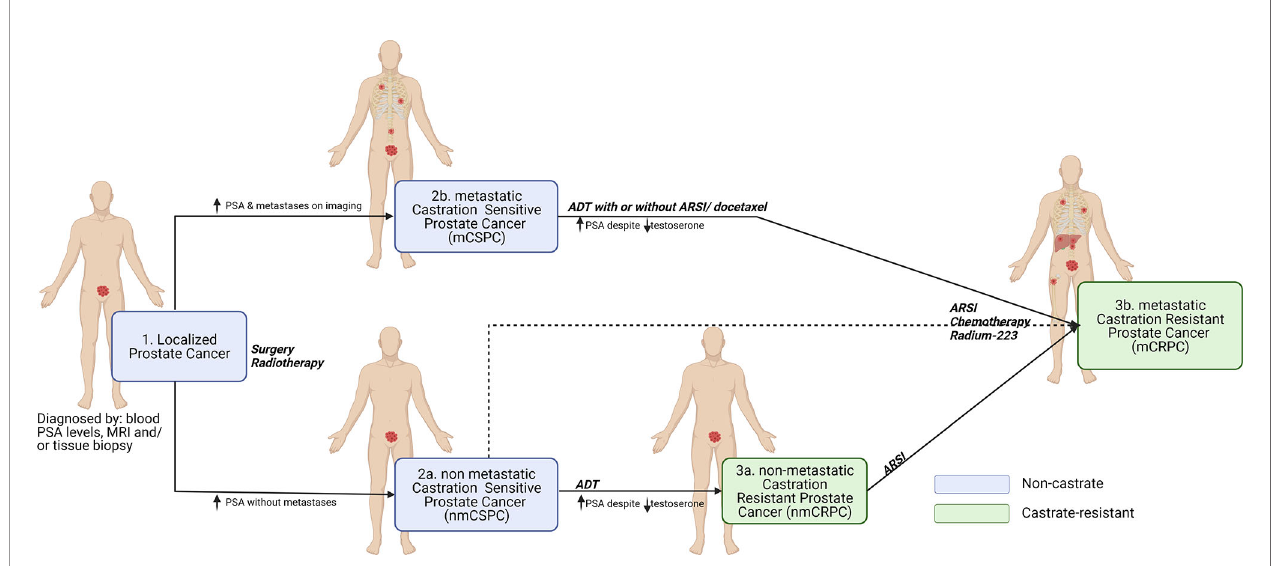
FIGURE 1 | Clinical disease states of prostate cancer. The onset of prostate cancer begins with the localized tumor formation in the prostate glands as diagnosed by blood PSA levels, MRI and/or tissue biopsy (1). However, some patients experience biochemical recurrence and can be diagnosed with high PSA levels with or without metastasis in distant regions of the body (e.g., Bone, lymph nodes, liver, and lungs) leading to non-metastatic castration sensitive prostate cancer nmCSPC (2a) or metastatic castration sensitive prostate cancer mCSPC (2b). Despite treatments with androgen deprivation therapy (ADT) with or without androgen receptor signaling inhibitor (ARSI) or chemotherapy (docetaxel), if the PSA and testosterone levels increase within the castrate range, then the disease is considered to have become (non)metastatic castration resistant prostate cancer (n)mCRPC (3a and 3b). To control the symptoms and to reduce the cancer progression, mCRPC is commonly treated with a combination of ARSI, radiotherapy (Radium-223) and chemotherapy. Created with